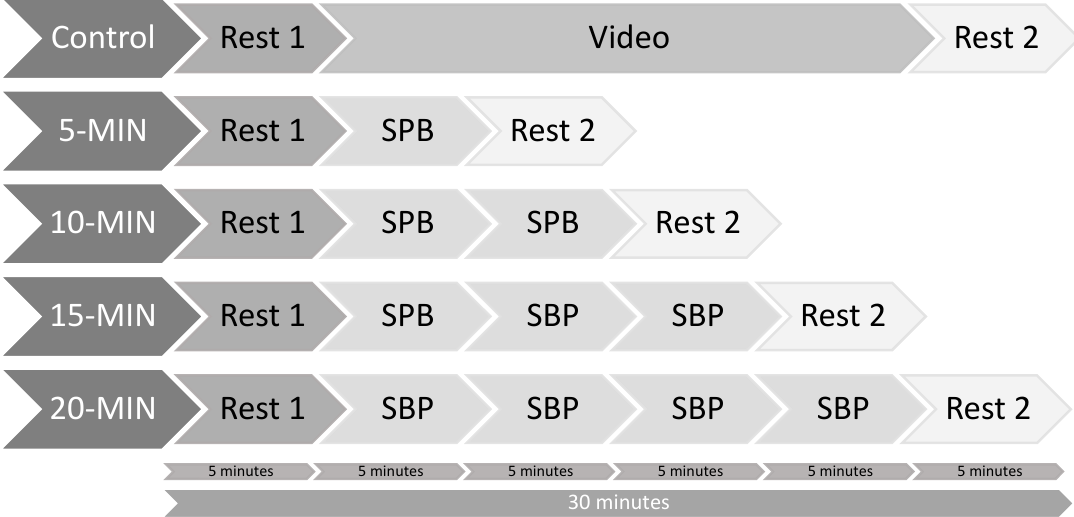
Figure 1. Experimental protocol. Note: SPB: Slow-paced breathing = 5 min; Rest = 5 min.